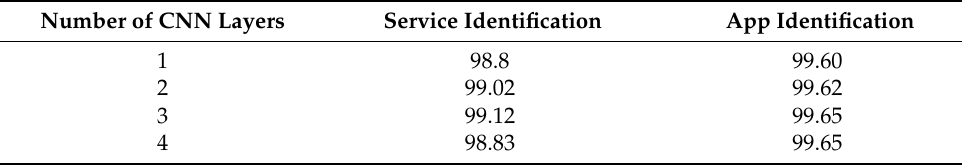
Table 5. Effect of the number of CNN layers